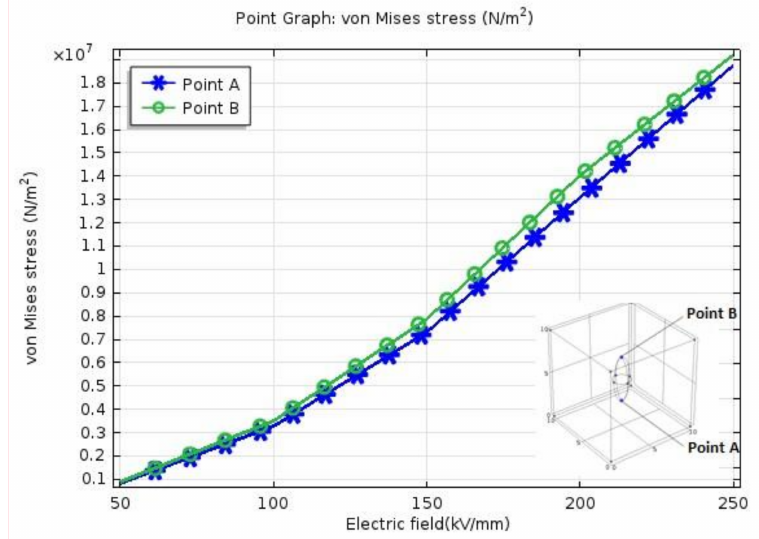
Figure 13. Von Mises stress with increasing electric field.